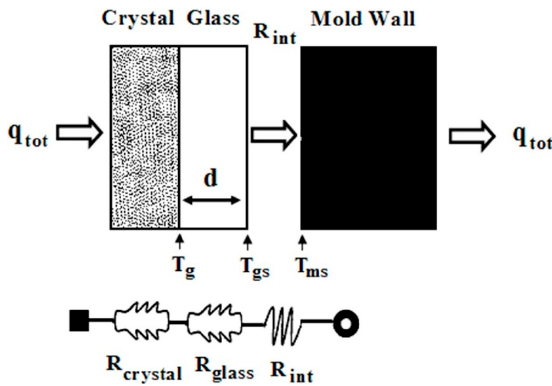
Figure 14. Schematic representation of heat flux across the mold flux film consisted of crystalline and glassy layers.